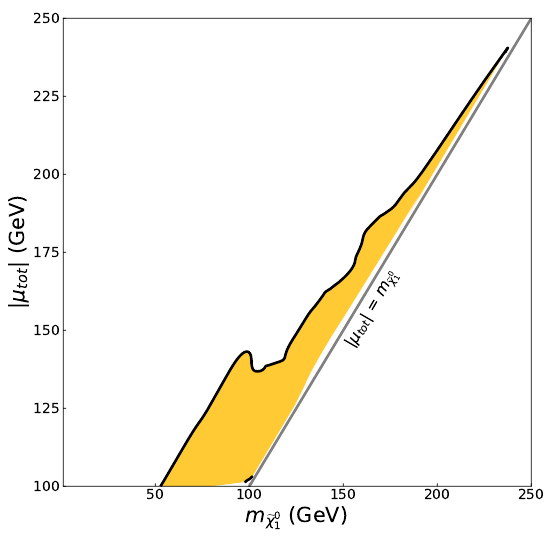
Figure 5 . Constraint from latest ATLAS analysis of di-lepton signal at 13-TeV LHC, which is shown on | µ plane. Analysis is concentrated on compressed mass spectra [86] and excludes the tot | − m ˜ χ 0 1 yellow-shaded region at 95% confidence level when λ = 0 . 01 and tan β = 10 are